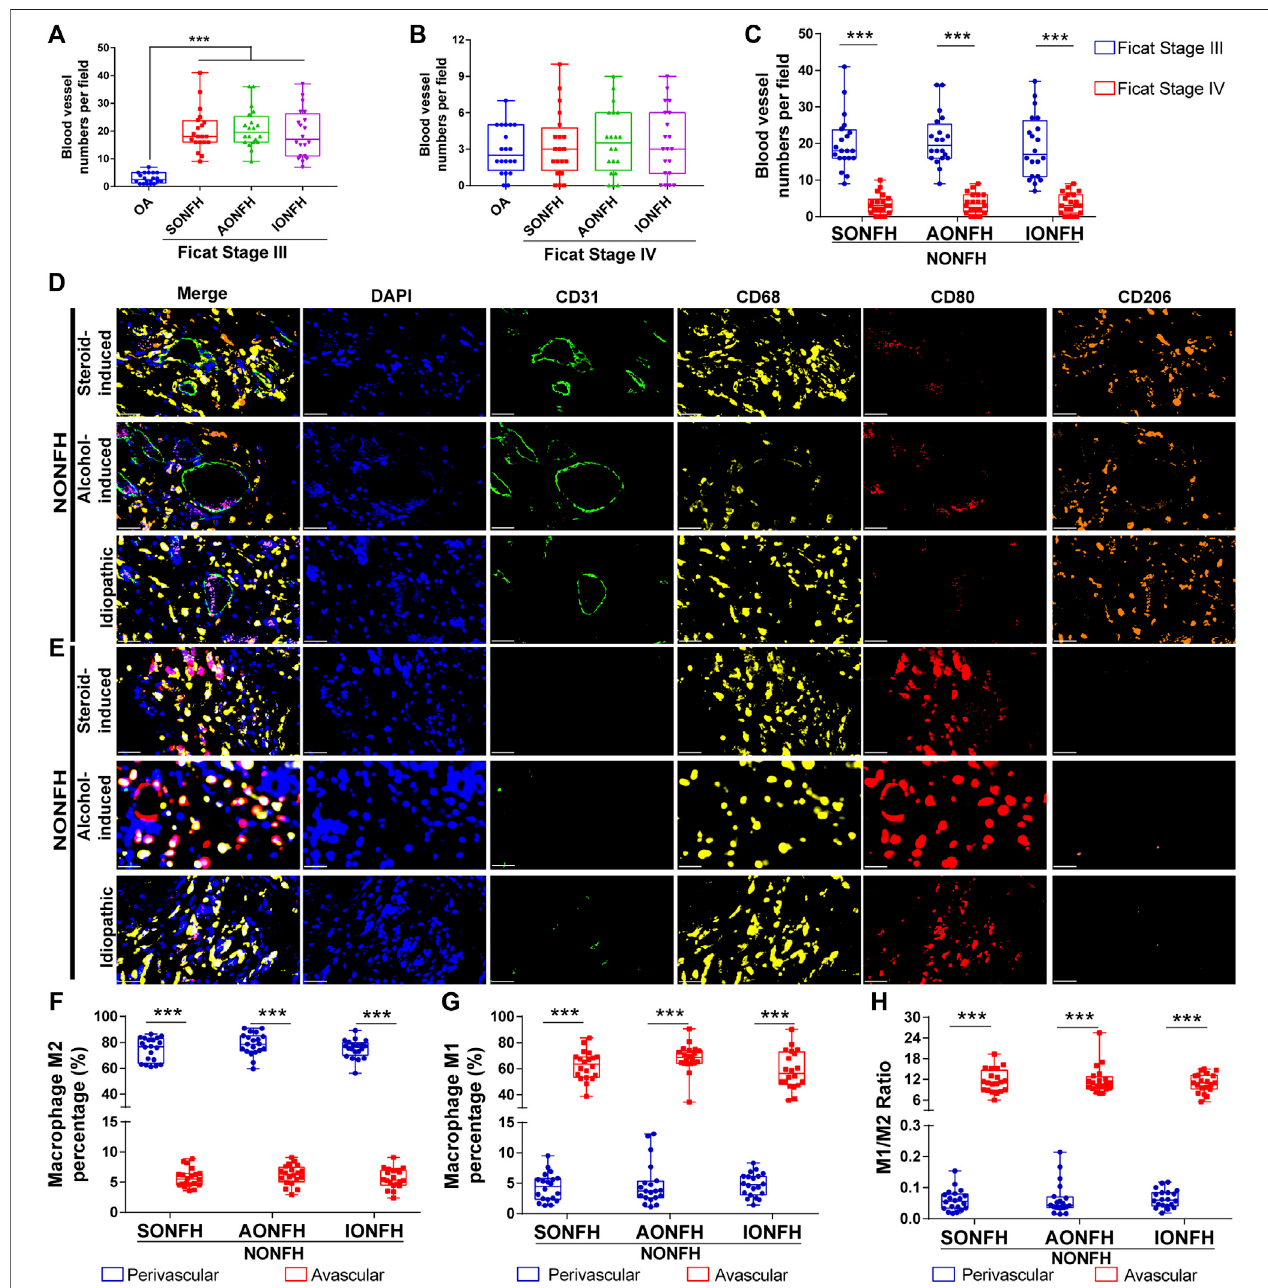
FIGURE 3 | Relative proportions of M1 and M2 macrophages were opposite in perivascular and avascular areas, and numbers of blood vessels increased in the reparative area during progressive stage of NONFH (A) Comparison of numbers of blood vessels between patients with different types of progressive-stage NONFH or with osteoarthritis (B) Comparison of numbers of blood vessels between patients with different types of end-stage NONFH or with osteoarthritis (C) Comparison of numbers of blood vessels between patients with progressive-stage or end-stage NONFH (D,E) Representative mIHC images of M1 macrophages (CD68 + CD80 + CD206 - ) and M2 macrophages (CD68 + CD80 − CD206 + ) in perivascular areas (identi fi ed based on CD31 + vascular endothelial cells) and avascularareasin thereparativeareainNONFH.Scalebar,50 μ m (F,G) Comparisonofpercentagesof (F) M2macrophagesand (G) M1macrophagesinperivascularandavascularareas in patients with different types of progressive-stage NONFH (H) Comparison of macrophage M1/M2 ratios in perivascular and avascular areas in patients with